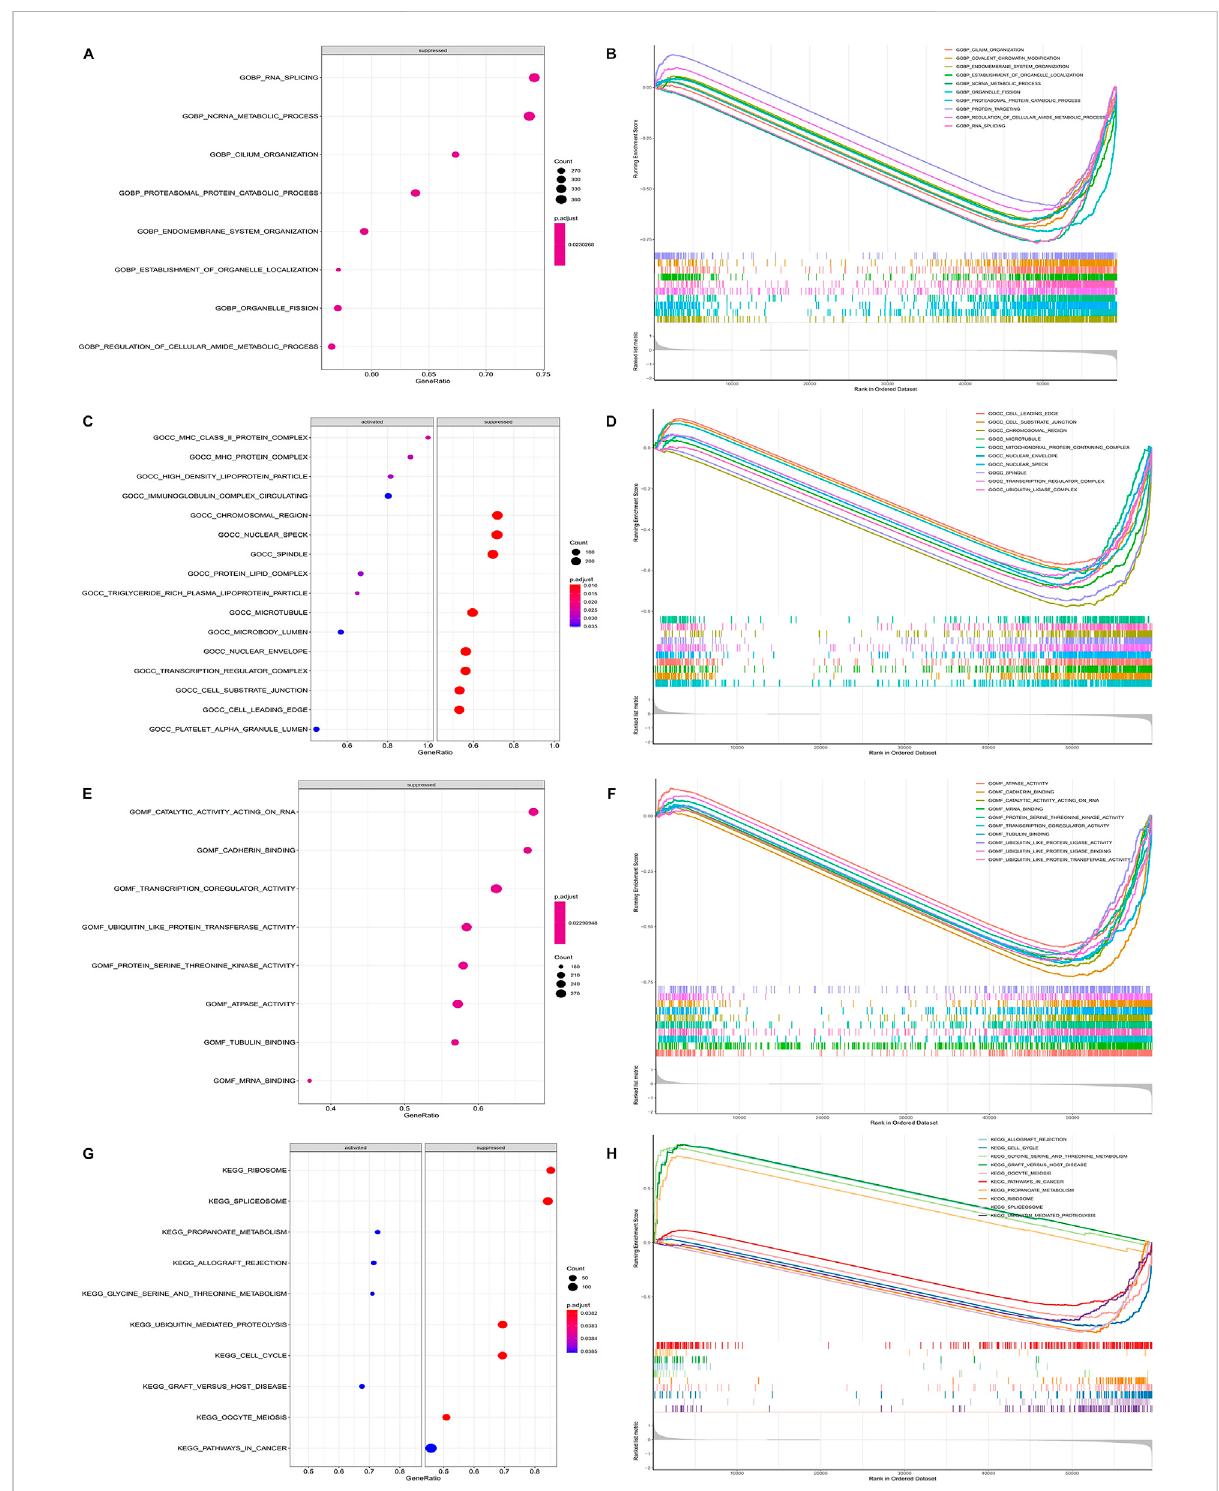
FIGURE 8 Functional enrichment of GSEA between high and low risk groups. (A) Plot of GSEA rich distribution points between high and low risk groups (GO-BP).Theverticalaxisisthefunctionalitem,thehorizontalaxisisthegeneproportion,theleft fi gureisthepathwayactivatedbyasinglegene,the right fi gure is the pathway suppressed by a single gene, the size of the dot is proportional to the number of genes, and the color is related to signi fi cance. (B) GSEA enrichmenttrendmap between high andlow riskgroups (GO-BP). (C) Plotof GSEArich distributionpoints betweenhigh